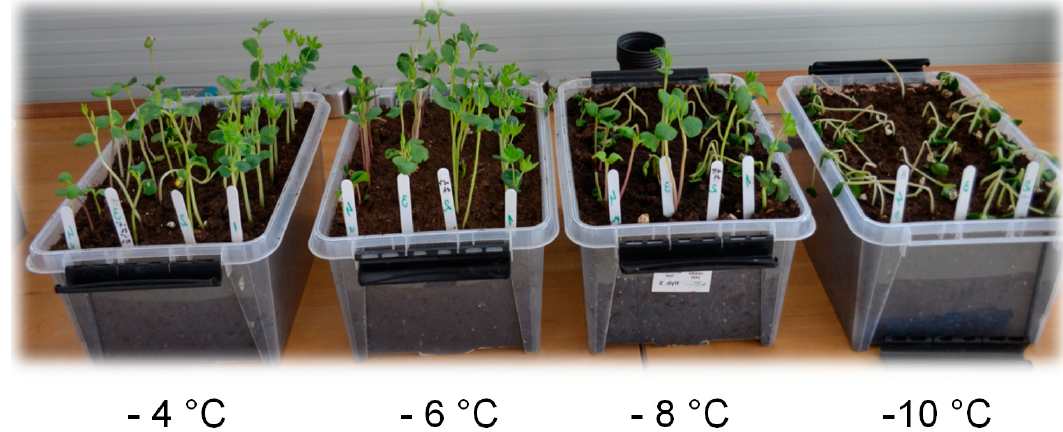
Figure 2. Seedlings test under artificial ‐ controlled conditions from low ( − 2 °C) to high ( − 10 °C) frost stress of four lupin accessions, L. albus cv. Mihai, L. mutabilis LIB 220, LIB 221 and LIB 222. Each container had 10 seedlings/accession, in total 40 seedling. Scoring was done at the develop ‐ mental phase 4.